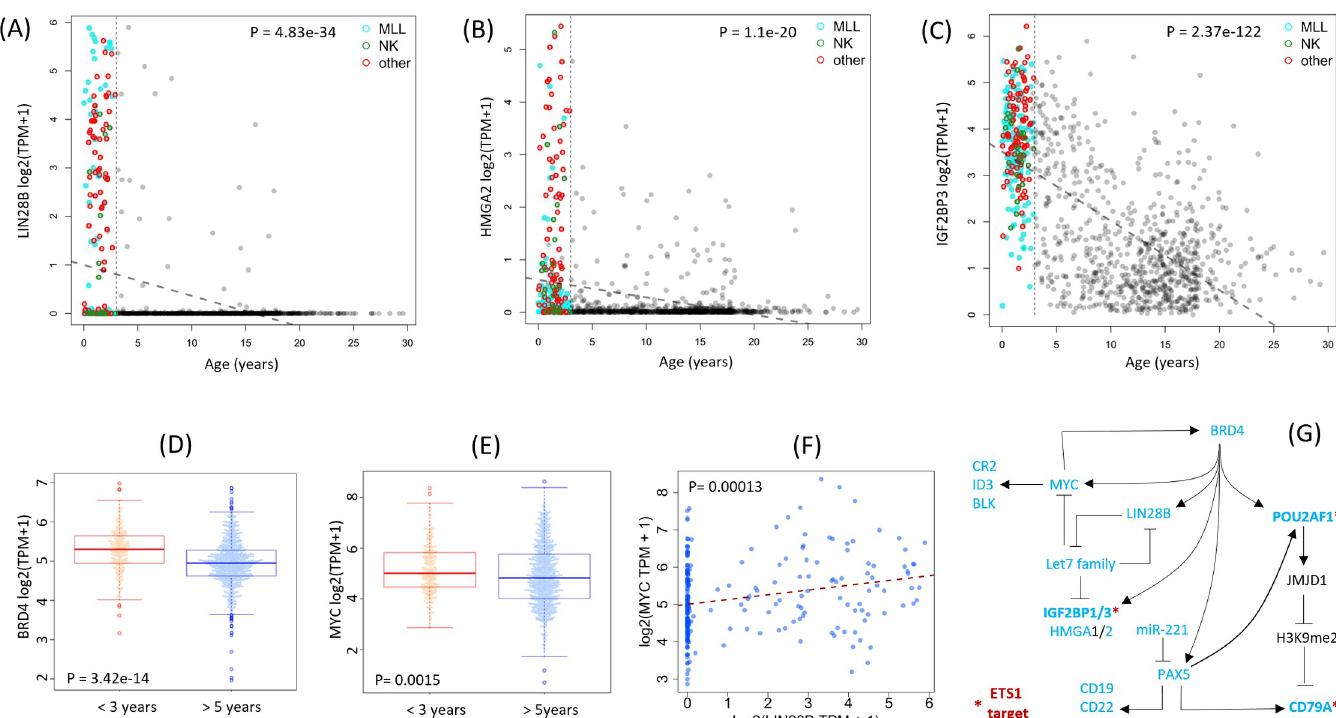
Fig 5. Up-regulation of a B-cell developmental gene regulatory network in infant AML. ( A-C ) Upregulation of LIN28B and its target genes HMGA2 and IGF2BP3 in infant AML. ( D, E ) BRD4 and MYC , which can form an auto-regulatory loop, are both up-regulated in infant AML, and there is a concomitant positive correlation between LIN28B and MYC expression ( F ). ( G ) Genes in a well-studied set of gene regulatory interactions involved in B-cell development are differentially regulated (cyan colored nodes) in AML. Genes marked by � are also known targets of ETS1 , which is also highly up-regulated in infant AML.